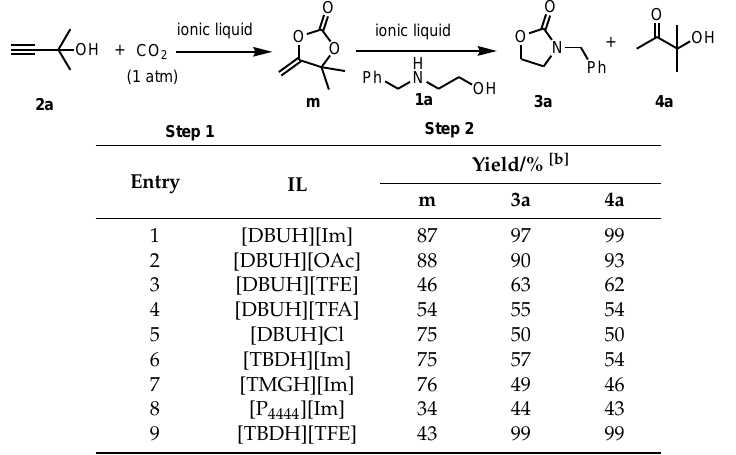
Table 4. Catalytic effect of ionic liquids to stepwise reactions in the domino reaction [a] .